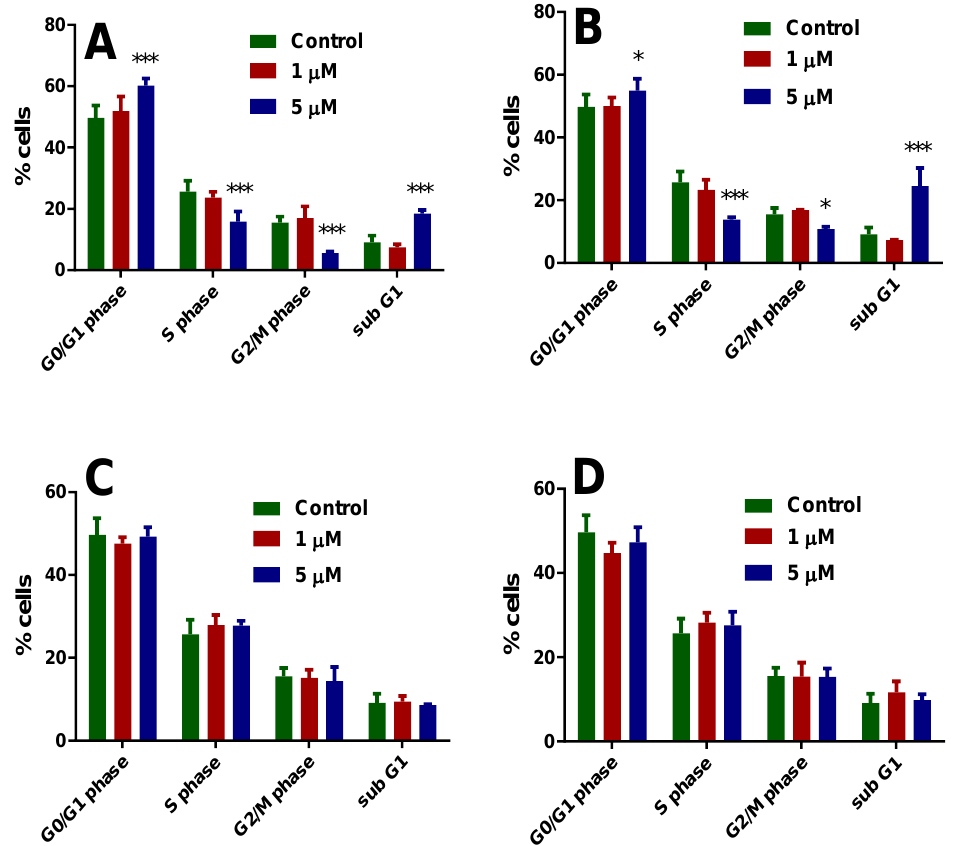
Figure 9. Changes in the cell cycle of B16 cells treated with 1 µ M and 5 µ M of complexes ( 1 ) ( A ), ( 2 ) ( B ), ( 3 ) ( C ), and ( 4 ) ( D ) for 24 h. The graphics represent the means ± SD of at least three independent tests. * p < 0.05, *** p < 0.001 (as compared to negative control using ANOVA one-way followed by Bonferroni ’ s post-test).